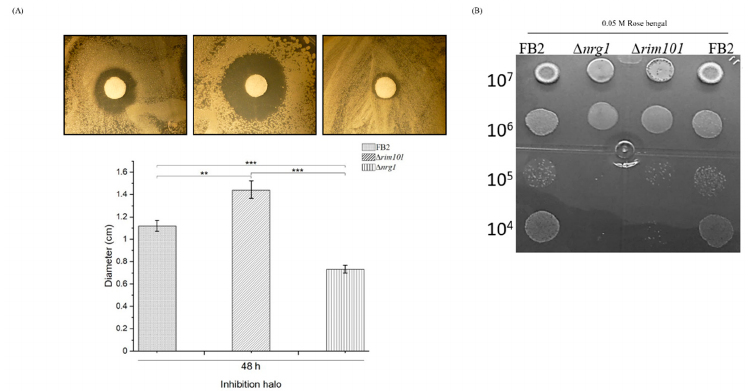
Figure 4. FB2, Δ rim101 and Δ nrg1 mutant strains effect of oxidative stress. ( A ) Wild type FB2 ( a2b2 ) and Δ nrg1 mutant derived from this strain was subjected to H 2 O 2 treatment as described in the text. ( B ) Wild type, ∆ rim101 and ∆ nrg1 strains were grown on Rose Bengal 0.05 M, for 48 h at